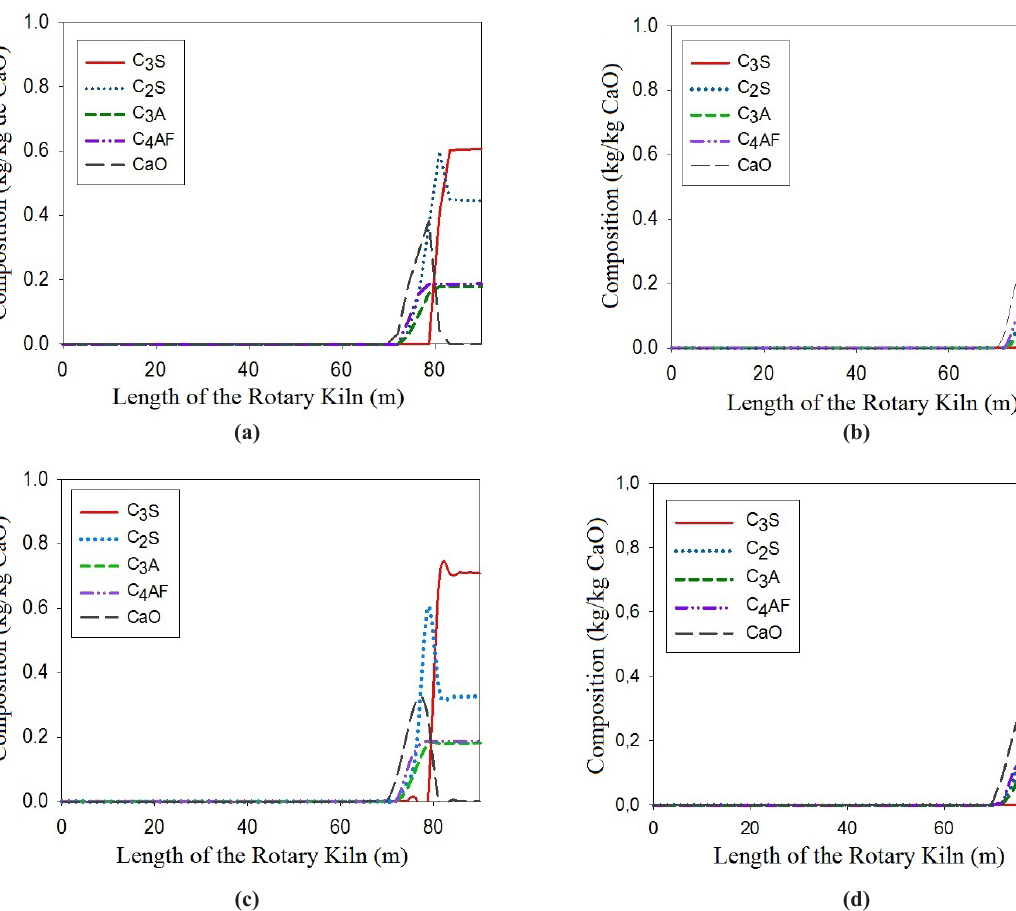
S, C S, C A, C AF and CaO in the industrial rotary kiln at steady state. ( a ) -20% of inlet solid 3 2 3 4